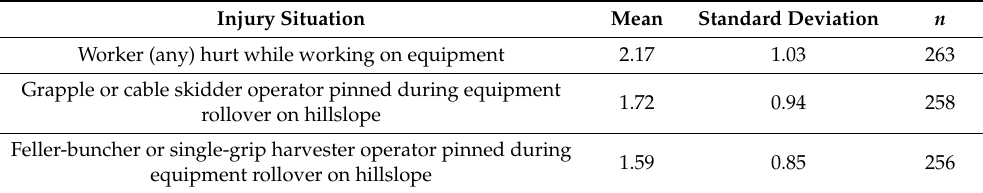
Table 7. Survey respondents’ evaluation of how common select injury situations relevant to equipment operators are on logging operations in the Inland Northwest, average of 1 to 5 scale (1 = not at all common, 5 = very